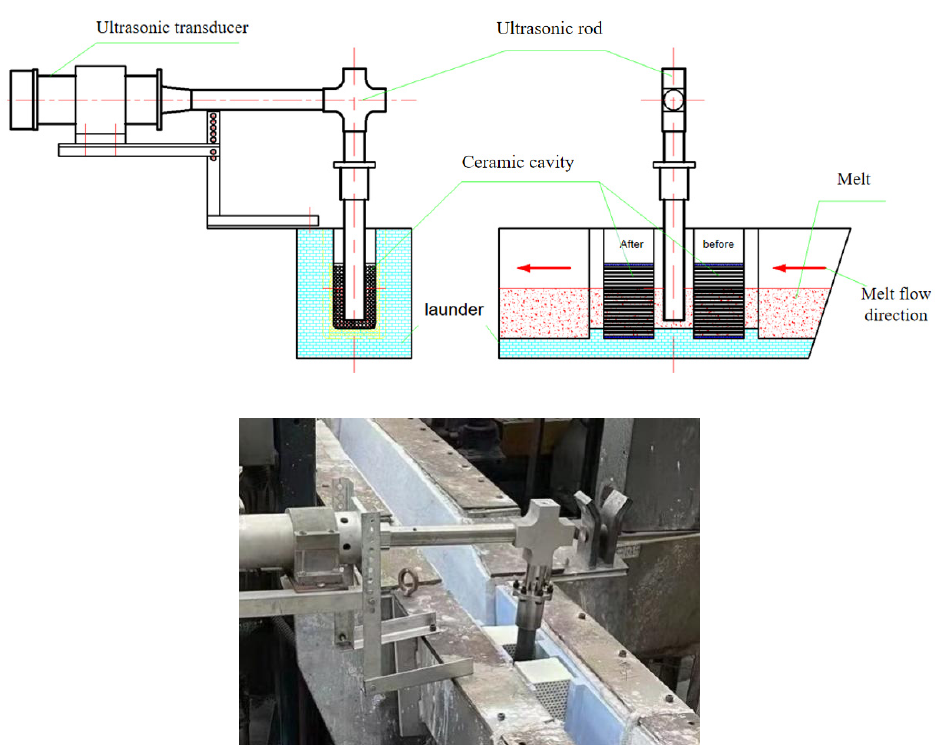
Figure 1. Two-dimensional image and physical photos of the online ultrasonic purification device for launder melt.